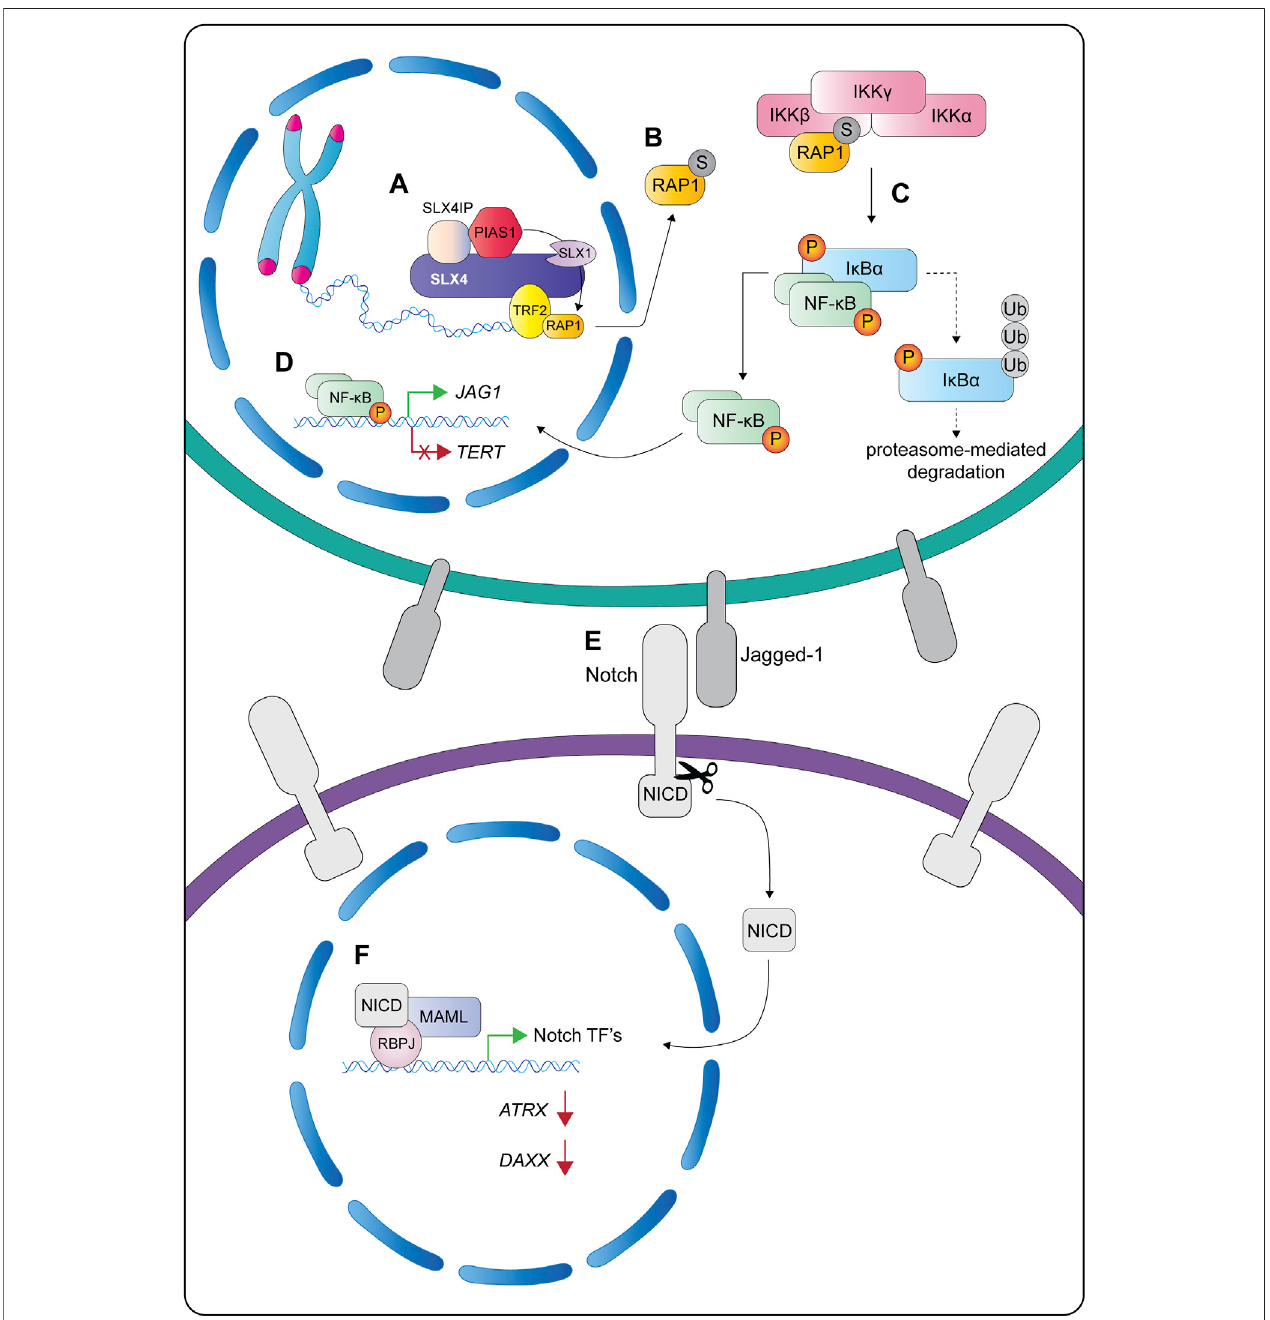
FIGURE10| ProposedmodelfortheroleofSLX4IPinpromotingRAP1SUMOylationandactivationoftheIKK — NF- κ B — NotchsignalingaxisincellsusingtheALT pathway. (A) SLX4IP is recruited to ALT telomeres through its interaction with SLX4. The presence of SLX4IP stimulates PIAS1 to SUMOylate RAP1 on K240. The SUMOylation of RAP1 reduces its ability to interact with TRF2 and SLX4, thus promoting its redistribution from the nucleus into the cytoplasm (B) . There, SUMOylated RAP1 activates NF- κ B signaling by binding to the IKK β subunit of the IKK complex. (C) The interaction between SUMOylated RAP1 IKK β triggers the phosphorylationandproteasome-dependentdegradationofI κ B α ,thusliberatingNF- κ Bandpromotingitstranslocationintothenucleus. (D) Onceinthenucleus,NF- κ